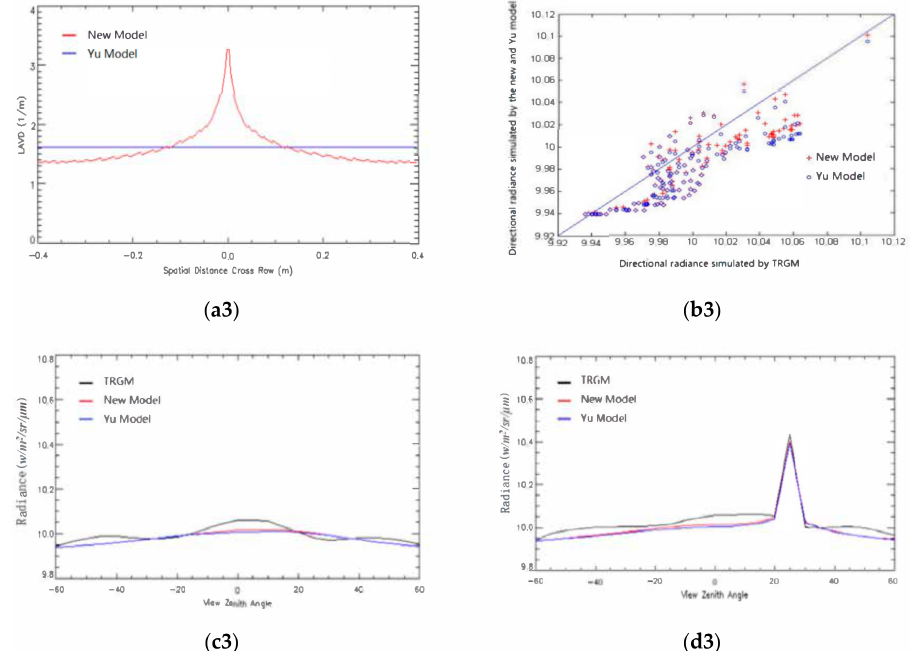
Figure 5. ( a1 ), ( a2 ), ( a3 ) The LAVD profiles crossing row simulated by the new model (red line) and Yu model (blue line) for growth stage 1, 2, and 3 separately. ( b1 ), ( b2 ), ( b3 ) The scatter plots for the DRs simulated by new model (red dots) and those by Yu model (blue dots) against those by TRGM for growth stage 1, 2, and 3 separately. ( c1 ), ( c2 ), ( c3 ) The DBTs simulated by TRGM (black line), the new model (red line), and Yu model (blue line) for growth stage 1, 2, and 3 separately in the crossing row plane. ( d1 ), ( d2 ), ( d3 ) The DBTs simulated by TRGM (black line), the new model (red line), and Yu model (blue line) for growth stage 1, 2, and 3 separately in the solar principle plane